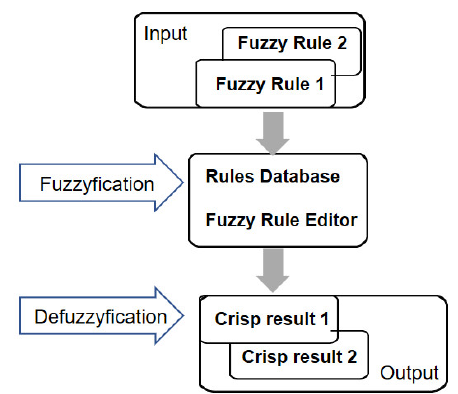
Figure 5. Reference model of the project is of the type: multiple entries—multiple outputs.